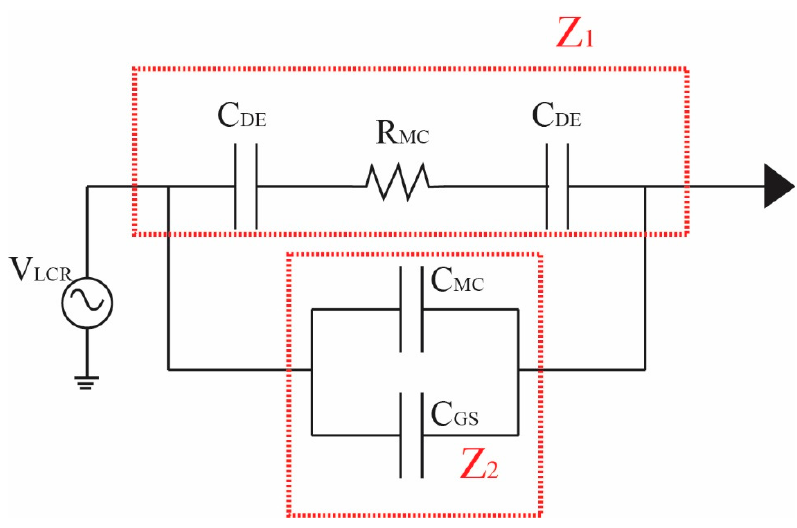
Figure 2. The electrical equivalent circuit of a microfluidic chip.